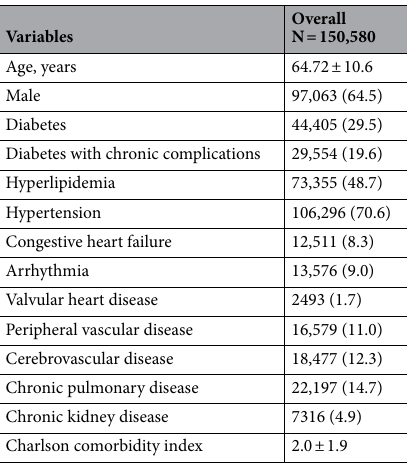
Table 1. Baseline characteristics of the study patients. Values are presented as number (percentage) or mean ± standard